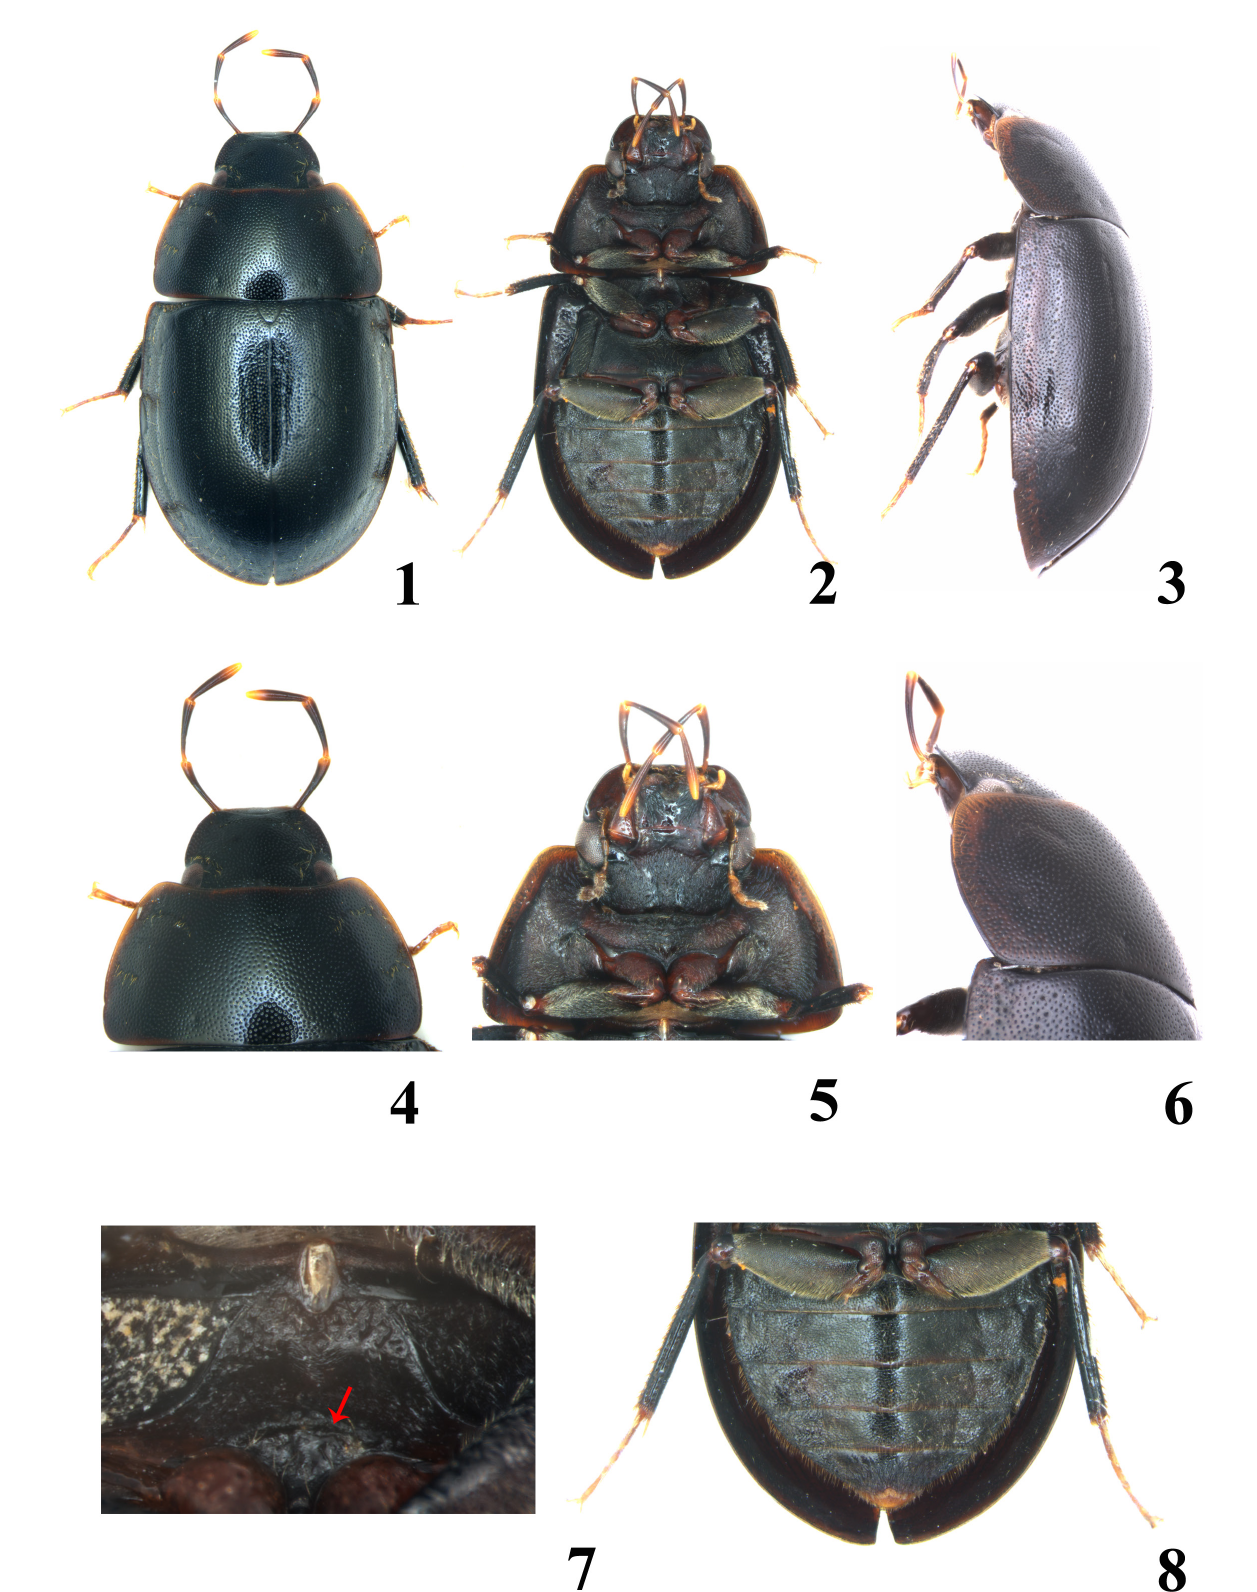
Figs 1–8. Helochares songi sp. nov. 1–3 . Habitus. 1. Dorsal. 2. Ventral. 3. Lateral. 4 . Head and pronotum. 5 . Head and prosternum. 6 . Pronotum, lateral. 7 . Mesoventrite. 8 .